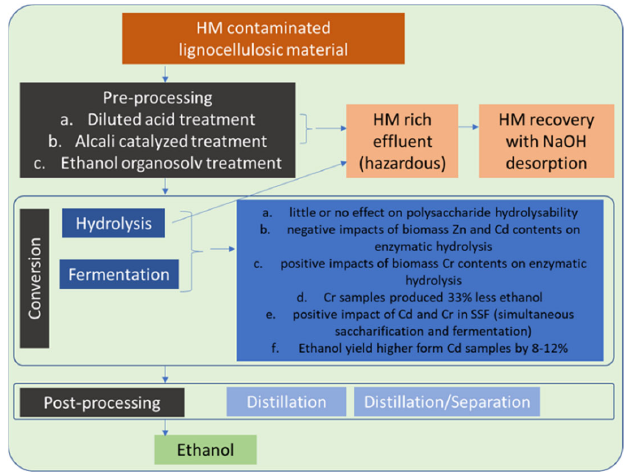
Figure 9. CVC1—Sugar to alcohols. Adapted clean value chain.